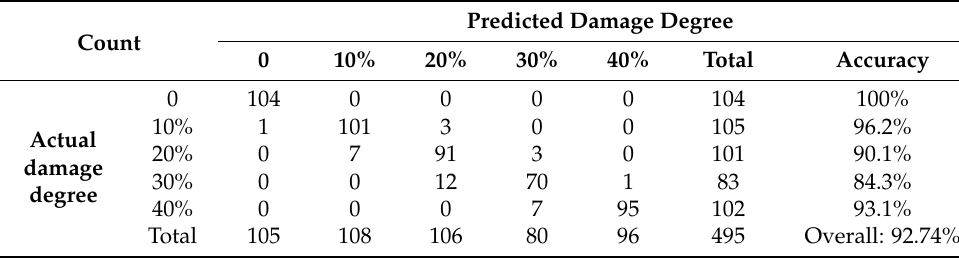
Table 5. The test